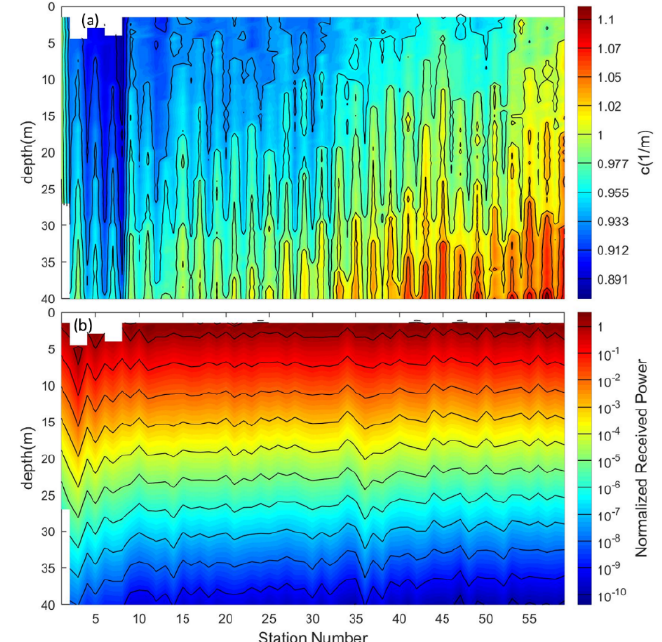
Figure 4. ( a ) Cross section of the observed volume attenuation coefficient c(z) along the tracks of NAVOCEANO Seaglider NG226 from January 25 to January 30, 2012, after Super Typhoon Guchol’s passage, and ( b ) the calculated normalized received power P n ( z ). The horizontal axis shows the glider’s location along the blue-colored track in Figure 2b with Station-1 located at 25°30′20” N, 131°59′51” E at 03:19 UTC, June 25, 2012, and Station-59 at 24°59′27” N, 131°59′26” E at 17:24 UTC, June 30, 2012. It is noted that Super Typhoon Guchol moved out of the area on June 18, 2012.